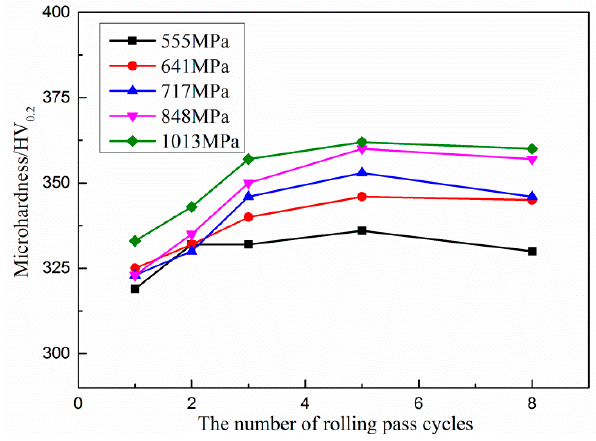
Figure 8. Influence of pass cycles on rolled surface microhardness.